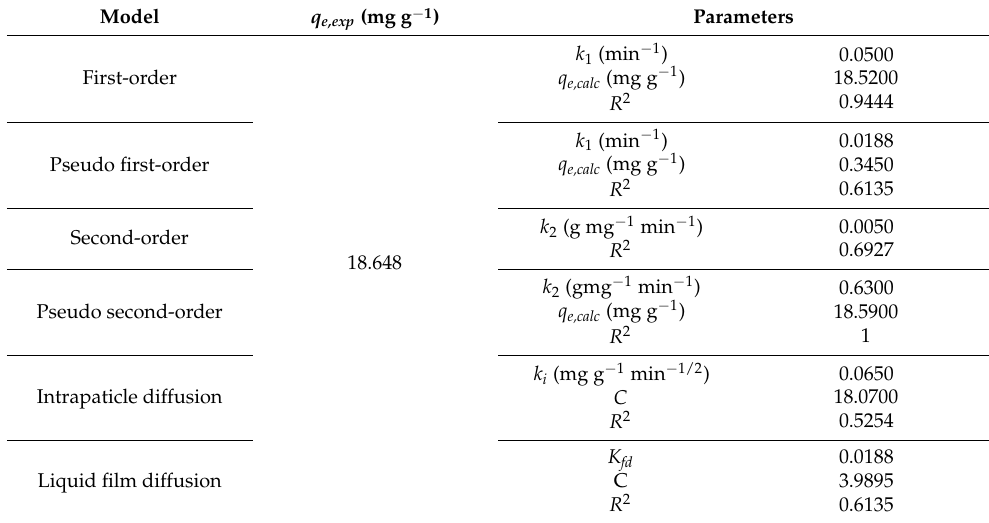
Table 4. Kinetic parameters for the sorption of MV onto